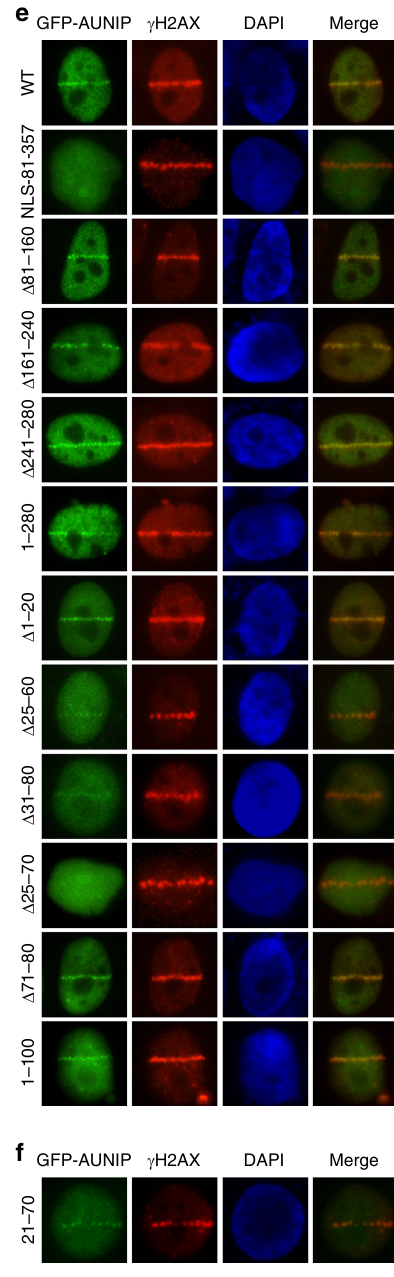
Fig. 2 AUNIP accumulates at perturbed replication forks and at sites of DNA damage. a Endogenous AUNIP accumulates at perturbed replication forks. AUNIP-SFB knock-in HeLa cells were either mock treated or treated with 1 μ M CPT for 6 h before they were processed for indirect immuno fl uorescent analysis for AUNIP-SFB ( α -Flag) and RPA2 ( α -RPA2). b GFP-tagged AUNIP is recruited to laser-induced DNA damage sites. U2OS cells transfected with GFP-tagged AUNIP were laser micro-irradiated. After 10 min, cells were stained with anti-RPA2 or anti- γ H2AX antibody. c AUNIP-SFB knock-in HeLa cells were laser micro-irradiated. Ten minutes post irradiation, cells were processed for immunostaining experiments using anti-Flag and anti-RPA2/ γ H2AX antibodies. d Schematic representation of AUNIP mutants used in this study. e Amino acids 25 – 70 of AUNIP is required for its recruitment to sites of DNA damage. Cells transfected with GFP-tagged wild-type AUNIP or its mutants were laser micro-irradiated. Cells were processed for